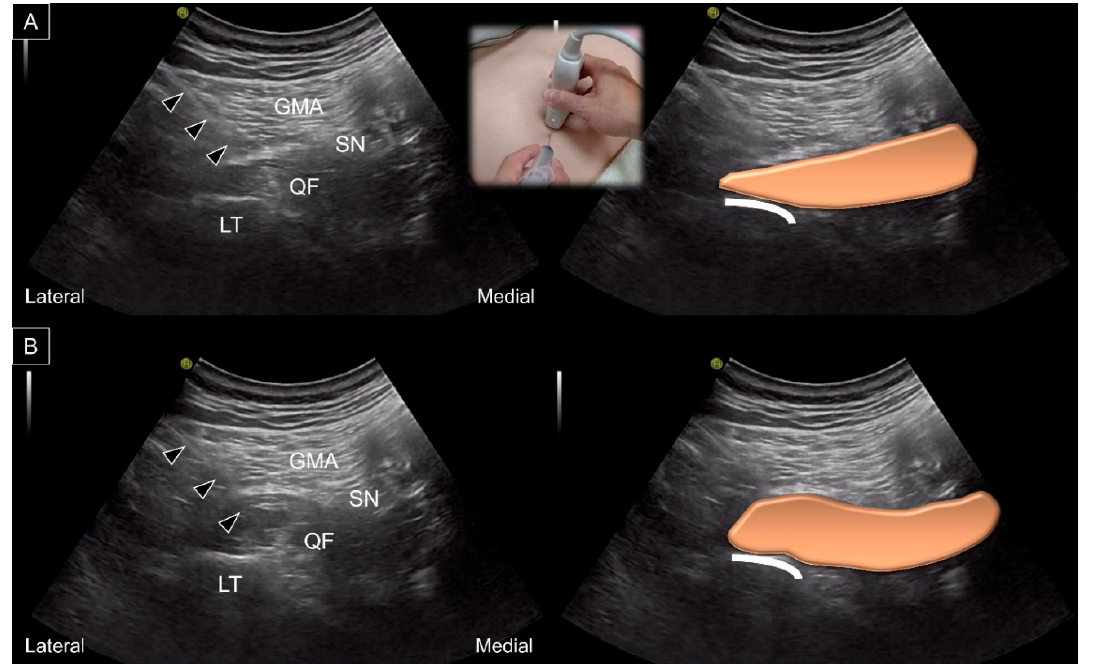
Figure 14. US images and guided injection of the quadratus femoris muscle performed using ( A ) the in-plane lateral-to-medial approach. ( B ) Note the intra-muscular distribution of the injectate. Black arrows: needle trajectory. GMA: gluteus maximus muscle; QF: quadratus femoris muscle, brown shade; LT: lesser trochanter; SN: sciatic nerve.